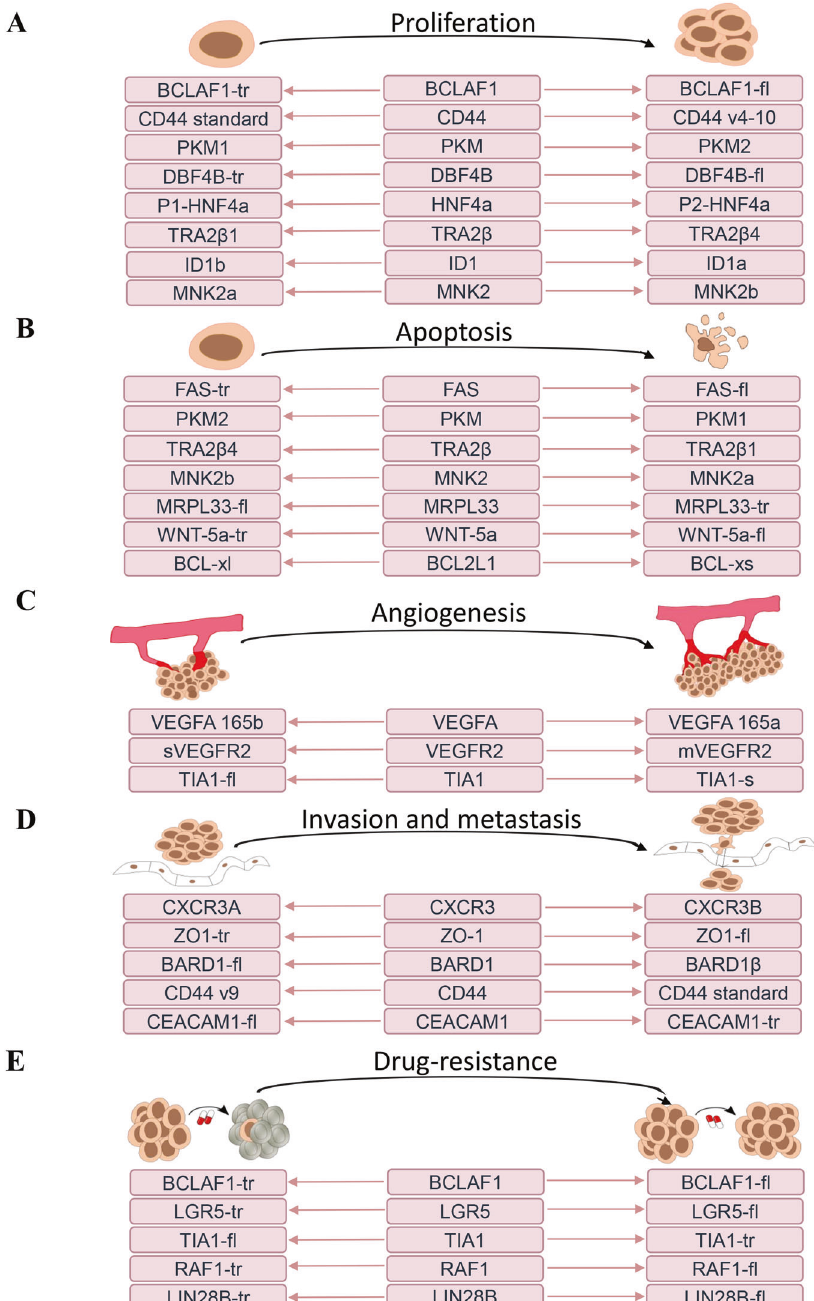
Fig. 3 Alternative splicing is associated with tumor hallmarks. Five common tumor hallmarks related to alternative splicing include proliferation, invasion and migration, apoptosis, angiogenesis, and drug resistance. The fi gure shows the hallmarks and the associated genes. A The representative gene and their splicing variants show different functions in cell proliferation. B The representative gene and their splicing variants show different functions in cell apoptosis. C The representative gene and their splicing variants show different functions in angiogenesis. D The representative gene and their splicing variants show different functions in invasion and metastasis. E The representative gene and their splicing variants show different functions in drug resistance. More details about the mechanism of splicing and clinical application are listed in Supplementary Table